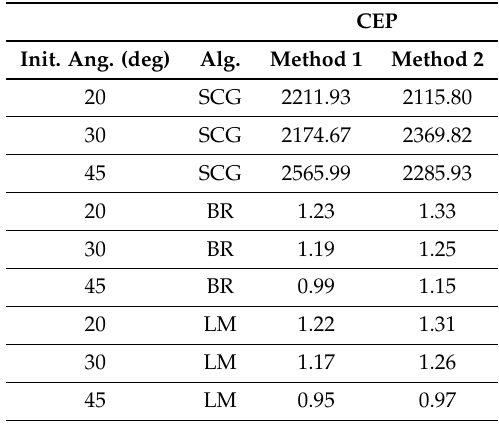
Figure 4. Detailed shots for different algorithms. Table 8. The CEP in neural network based controlled flights for the different methods and training algorithms for 20 ◦ , 30 ◦ and 45 ◦ initial pitch